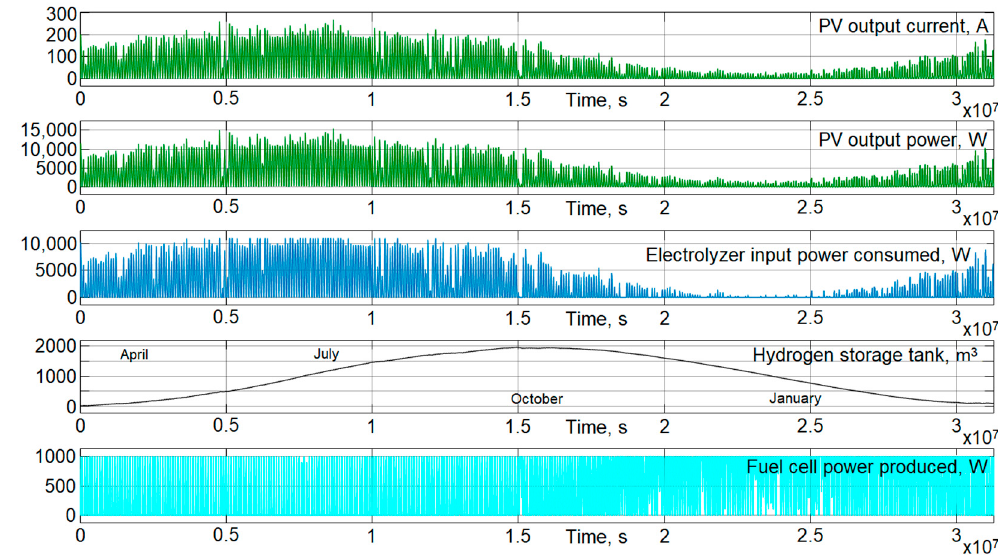
Figure 16. The parameters (current and power) of consumption in each location are equal.